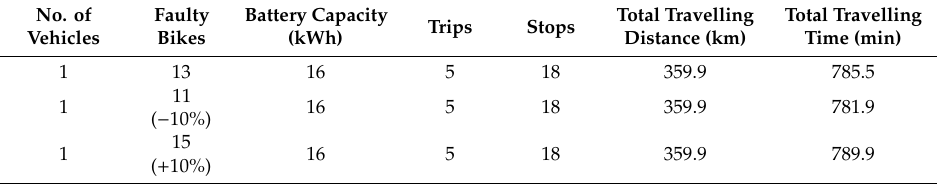
Table 15. The optimal solutions under di ff erent numbers of faulty bikes in the